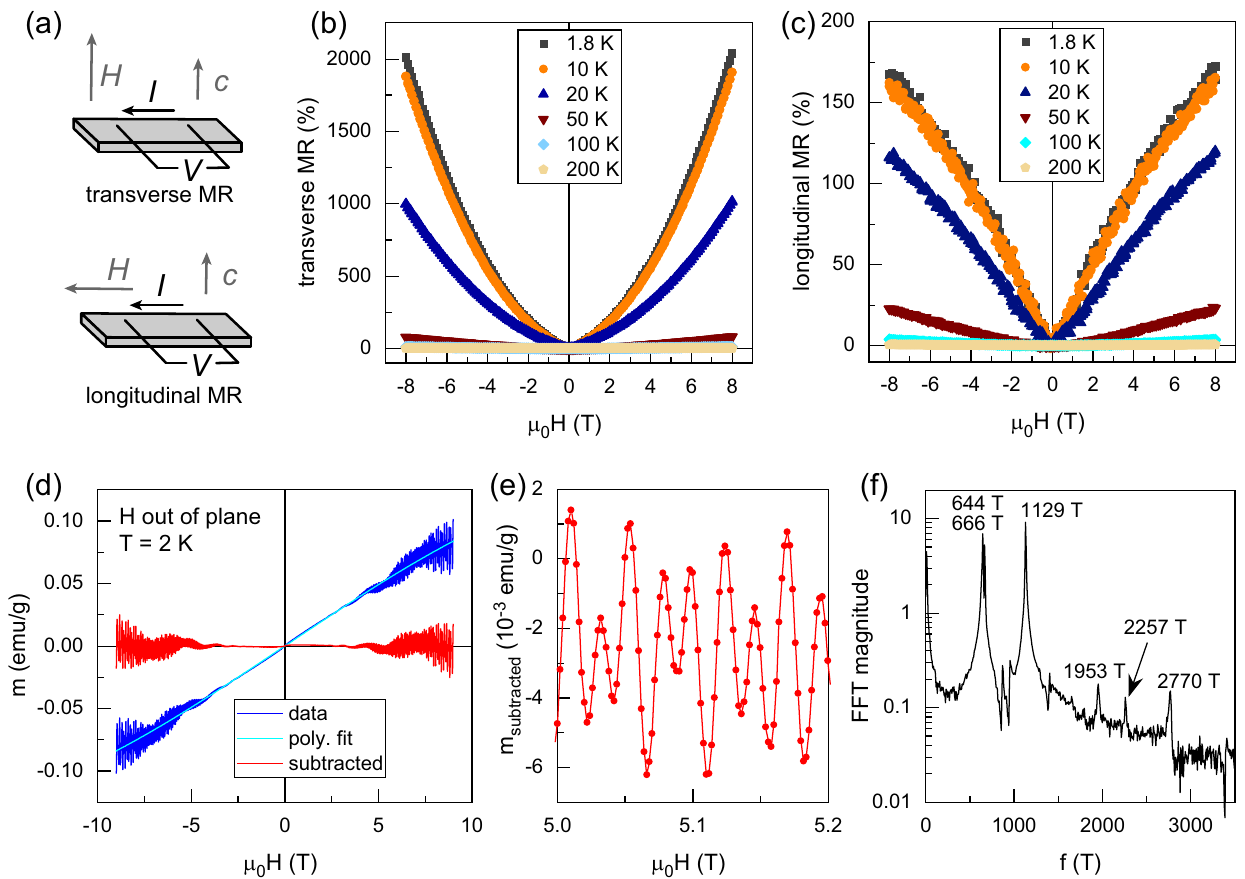
Fig. 4 Magnetic fi eld dependence of the resistivity and magnetization of Ni 3 In 2 S 2 . a Relative orientations of the current I , magnetic fi eld H , and crystallographic c -axis (conventional setting) for the magnetoresistance measurements. b , c Transverse and longitudinal magnetoresistance MR(%) = [R(H) − R(0)]/R(0) × 100 measured at the indicated temperatures. d Measured magnetization in blue with quantum oscillations clearly seen at higher fi elds. The oscillating part of the signal (red) is determined by subtracting a polynomial fi t (cyan) to the measured data, and is shown over a small fi eld range in ( e ). f Results of Fourier transforming of the oscillating component vs.